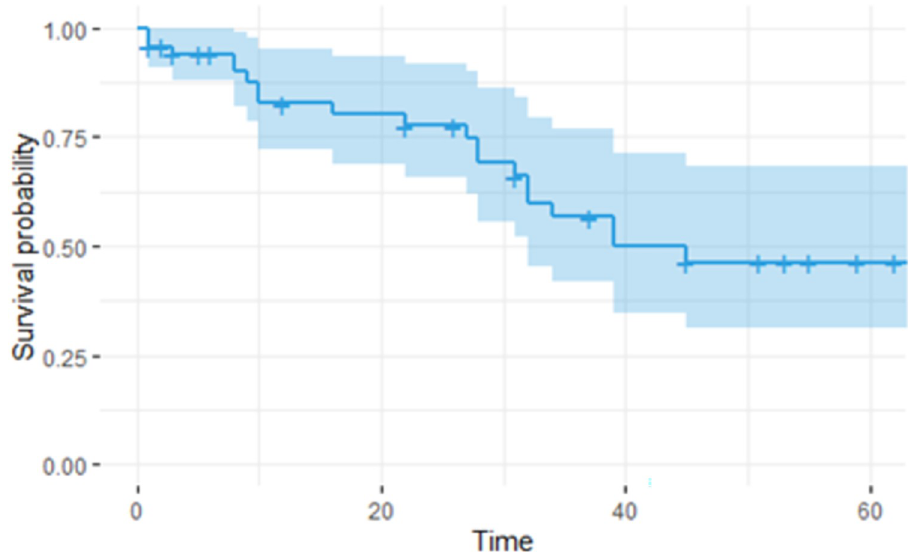
Fig 2. Survival curve of red squirrels Tamiasciurus fremonti fremonti after translocation, from the first day of release until 60 days after the release (usually corresponding also to the end of the field season). On the x-axis is represented the time in days after translocation, while on the y-axis is represented the survival probability, starting as 1 the day of the animal release and decreasing until just below 0.5 after 40 days.